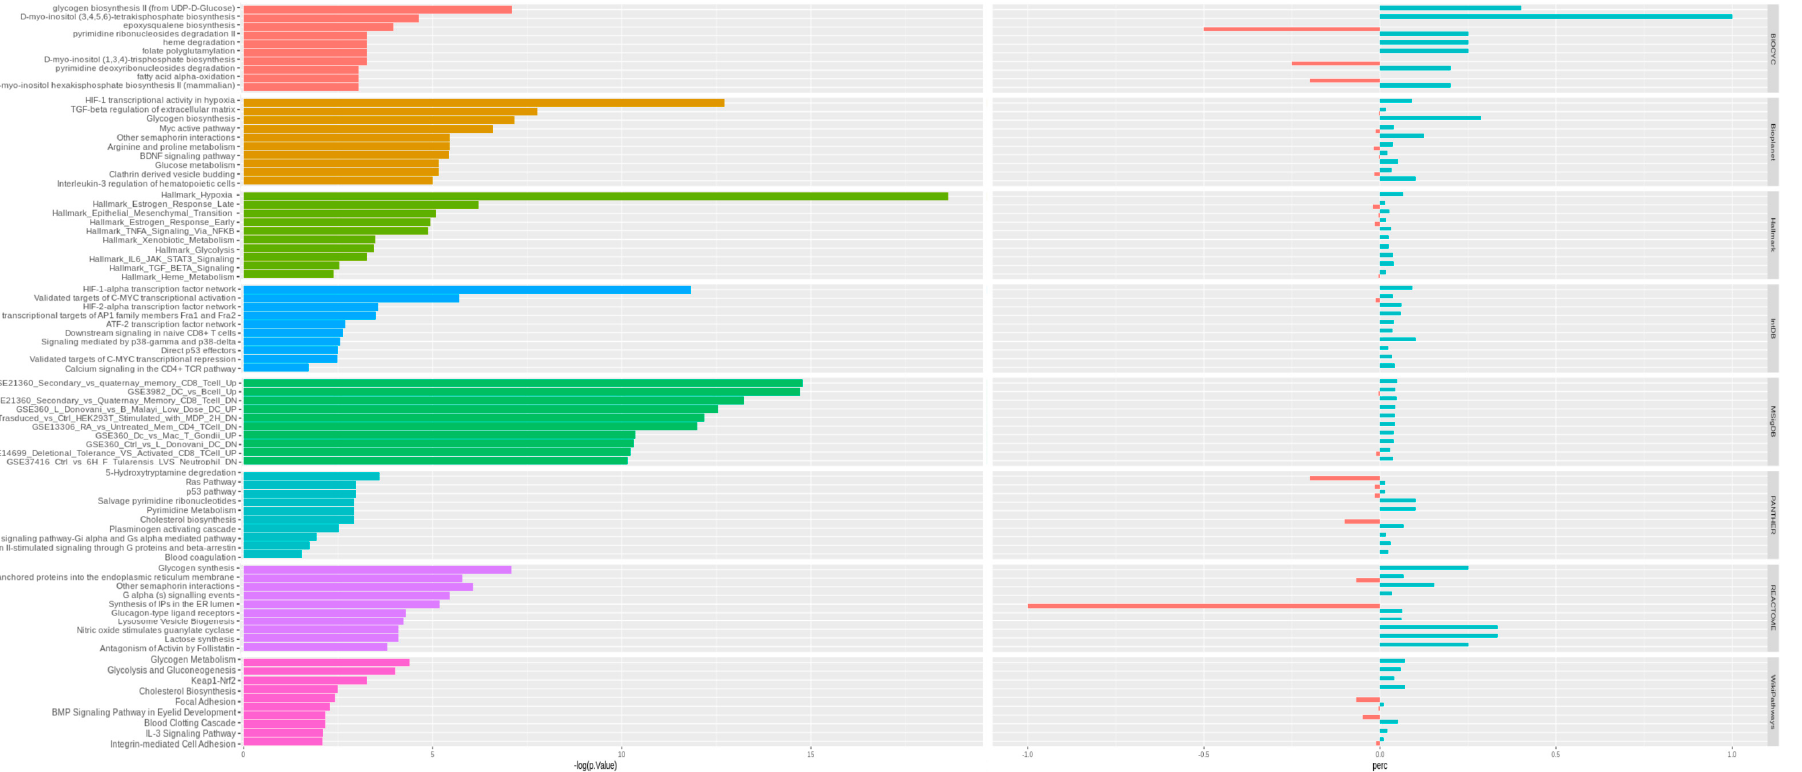
Figure 2. Enriched pathways. Bar plot ( left ) reporting the main significantly enriched biological processes extracted by different ReviGO databases, enrichment score > 3. Stacked bar plot ( right ) accounting for proportions of upregulated and downregulated genes for each biological process. The top 10 pathways by p -value were extracted from the main databases. For each pathway, the percentage of significant genes contained in the term was calculated.